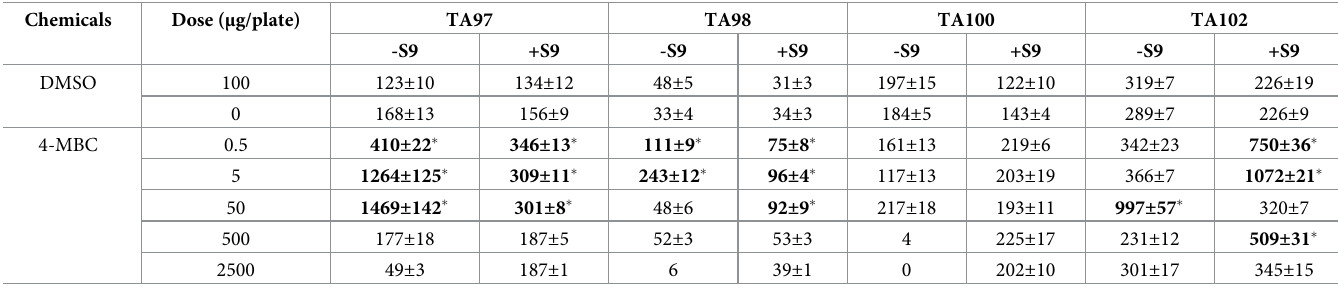
For the TA97 and TA102 strain (Table 2 and Fig 2), BP-8 showed mutagenicity only at one dose (5 μ g/plate for TA97 strain and 2500 μ g/plate for TA102 strain) without S9. When the S9 was added, mutagenicity was detected at several doses. For the TA98 strain, in the system with or without S9, positive mutagenicity was both detected. For the TA100 strain, no significant mutagenicity was detected at all concentrations with or without S9. The highest concentrations of BP-8 caused a strongly inhibited effect on the TA97, TA98, and TA100 strains. For both TA97 and TA98 strain (Table 3 and Fig 3), the significant mutagenic effects were detected from 4-MBC both in the systems with and without S9. Furthermore, the reverse mutation colonies decreased in S9 added system. For the TA100 strain, no mutagenic activity was detected at all doses with and without S9, which was similar to BP-8. For the TA102 strain, significant mutagenicity was only detected at the dose of 50 μ g/plate without S9. After adding S9, mutagenicity was also detected from the doses of 0.5, 5, and 500 μ g/plate. The highest con- centrations of 4-MBC inhibited on the TA97 and TA98 strain without S9. Mixed Ames test results Tables 4 and 5 are the reverse mutation colonies of four S . typhimurium strains at different doses of the mixture of BP-6 and 4-MBC and the mixtures of BP-6, BP-8, and 4-MBC with and without S9. The MR values at every dose are compared in Figs 4 and 5. For the TA97 and TA102 strain (Table 4 and Fig 4), the MR value was � 2 at two ratios without S9 (MR was 2.7 and 3.6 for TA 97 strain while 7.3 and 8.3 for TA100 strain). However, the mutagenicity was not detected when S9 was added. For the TA98 strain, mutagenicity was Table 3. Reverse mutation colonies of four S . typhimurium strains exposed to 4-MBC with and without S9. Chemicals Dose ( μ g/plate)